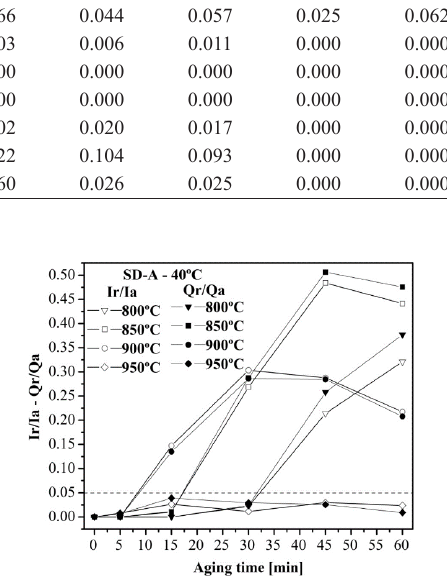
/I and Q /Q versus aging time for SD-A in 2.00 M H r a r a